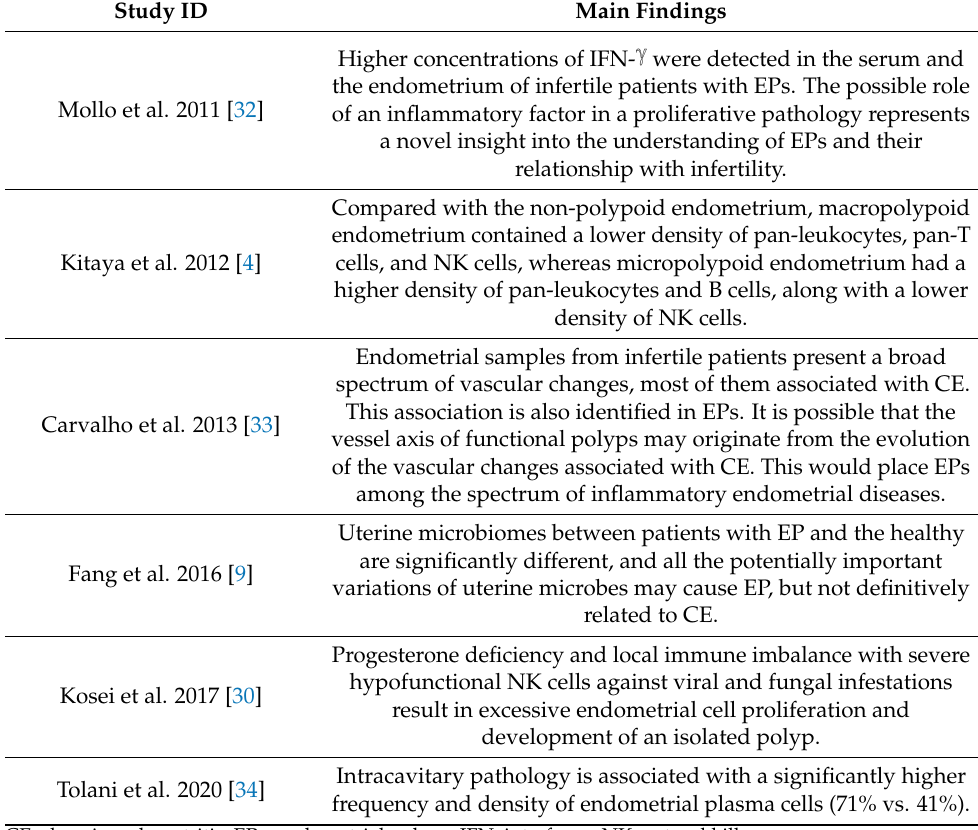
Table A2. Main findings of the studies excluded after full text screening. Study